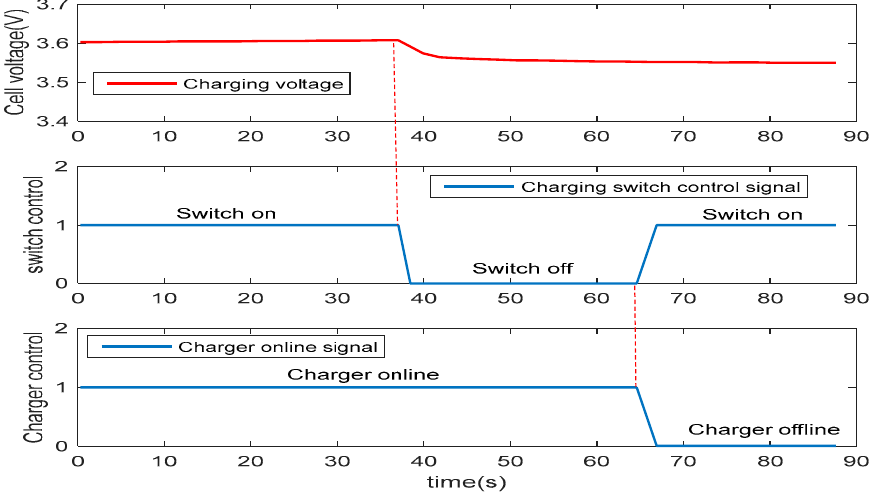
Figure 16. Over-charged fault detection and self-recovery curve.